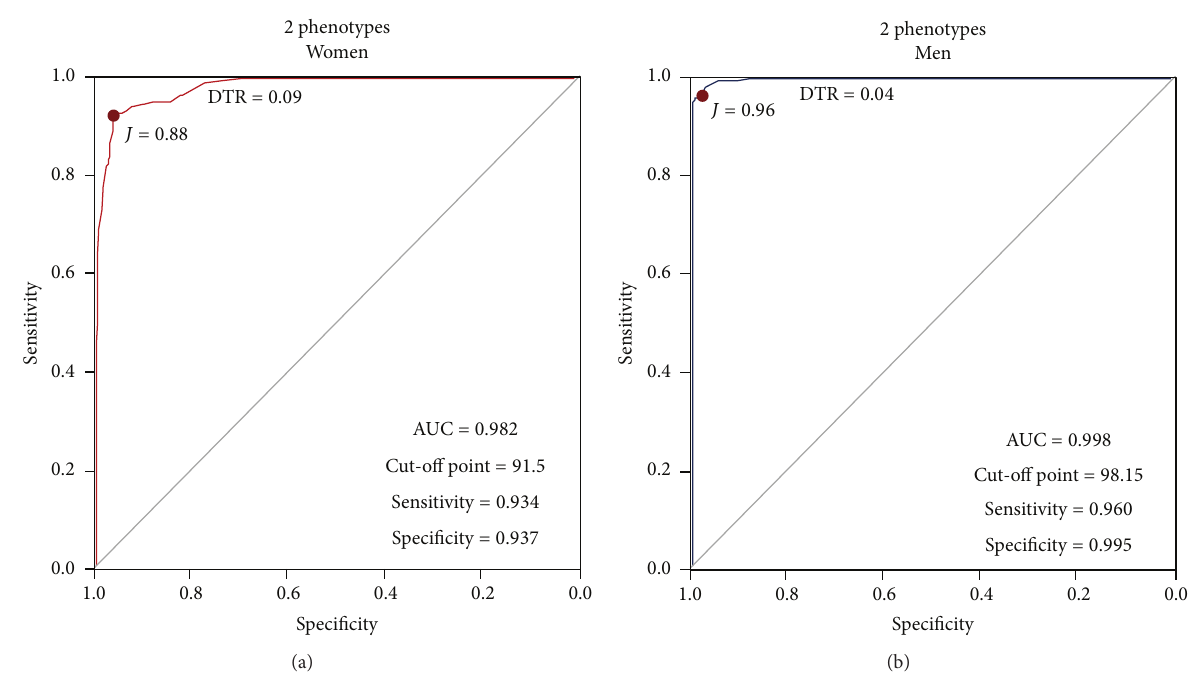
Figure 5: ROC curves constructed using 2 phenotypes, after exclusion of Overweight groups.